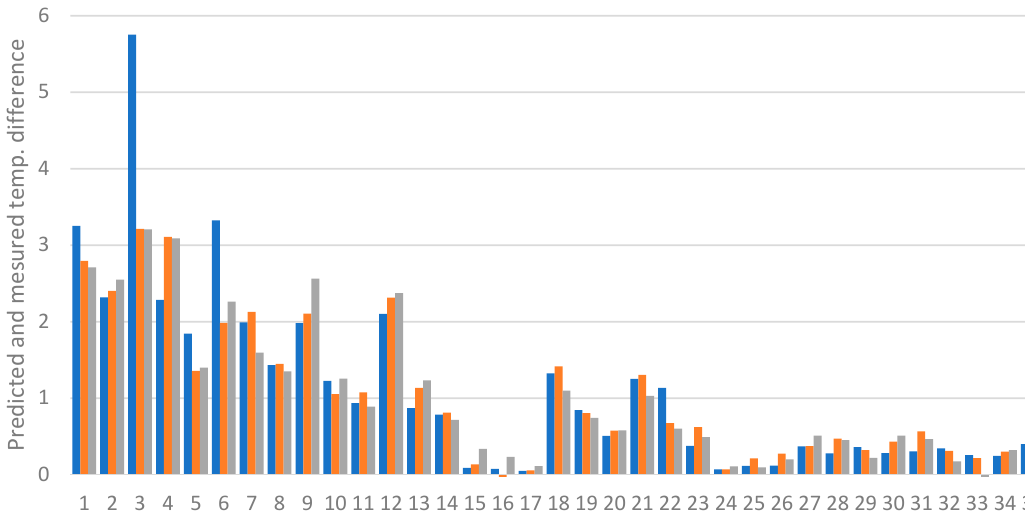
Table 3. Experiment inputs, outputs and predicted output (based on the testing set) of optimized ANFIS and percentage difference between outputs. Figure 9. Column bar chart representing the temperature di ff erences between experimental values ∆ T (blue bars), predicted PSO-ANFIS ∆ T case 2 best (orange bars) and ANFIS ∆ T case 1 (gray bars). The average di ff erence between the experimentally measured temperature drop ( ∆ T) and the temperature drop predicted by the ANFIS based on the LOSO testing set in case 1 ( | ∆ T − ∆ T case1 | ) was ◦ equal to 0.3450 C, while the optimized ANFIS structure in case 2 achieved an average temperature di ff erence between the experimentally measured temperature drop ( ∆ T) and the temperature drop ◦ predicted by ANFIS based on the LOSO testing set ( | ∆ T − ∆ T case2 best | ) equal to 0.2619 C. Neural networks combined with fuzzy logic in the ANFIS system o ff er an insight into their decisions. Figure 10 presents the Fuzzy interference system (FIS) properties of the discussed ANFIS. Output ( ∆ T represented by a first order Sugeno model) was calculated based on eight IF-THEN rules that represent all combinations of input MFs ( = 2 3 ). The premise parameters are stated as a i and c i , where a represents the mean and c the width of the i -th Gaussian MF. The first rule states